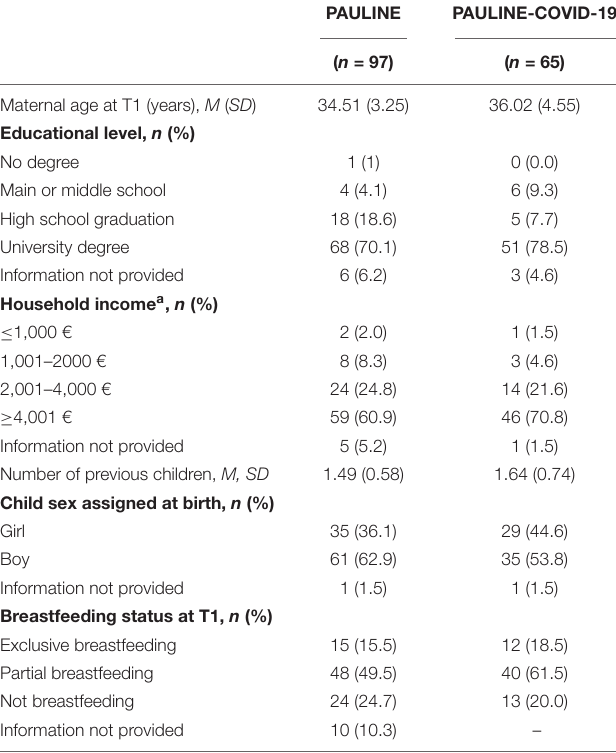
TABLE 1 | Characteristics of the